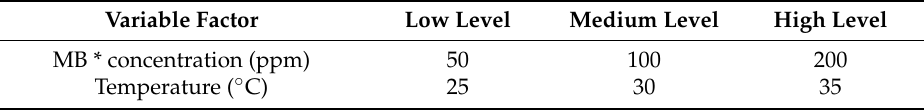
Table 1. Levels and variables involved in the study.